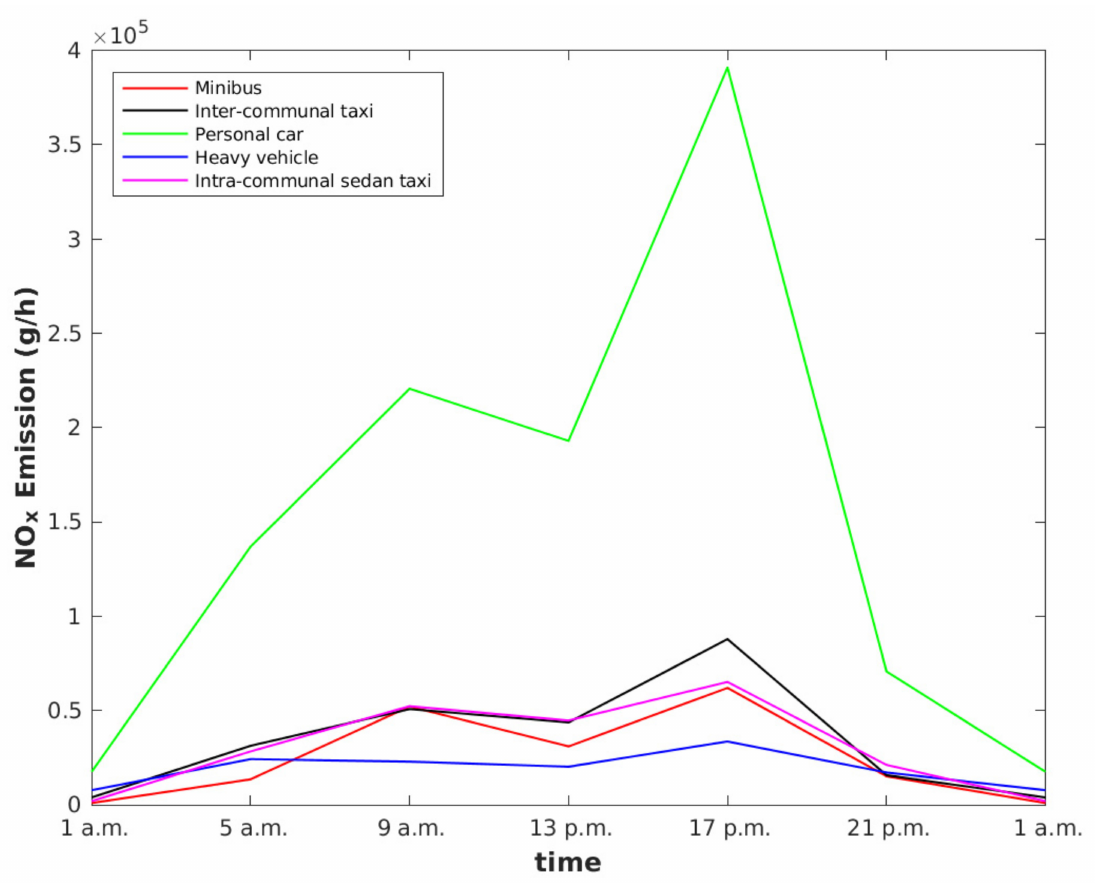
Figure 8. Total vehicle emission of NO x for different vehicle types in